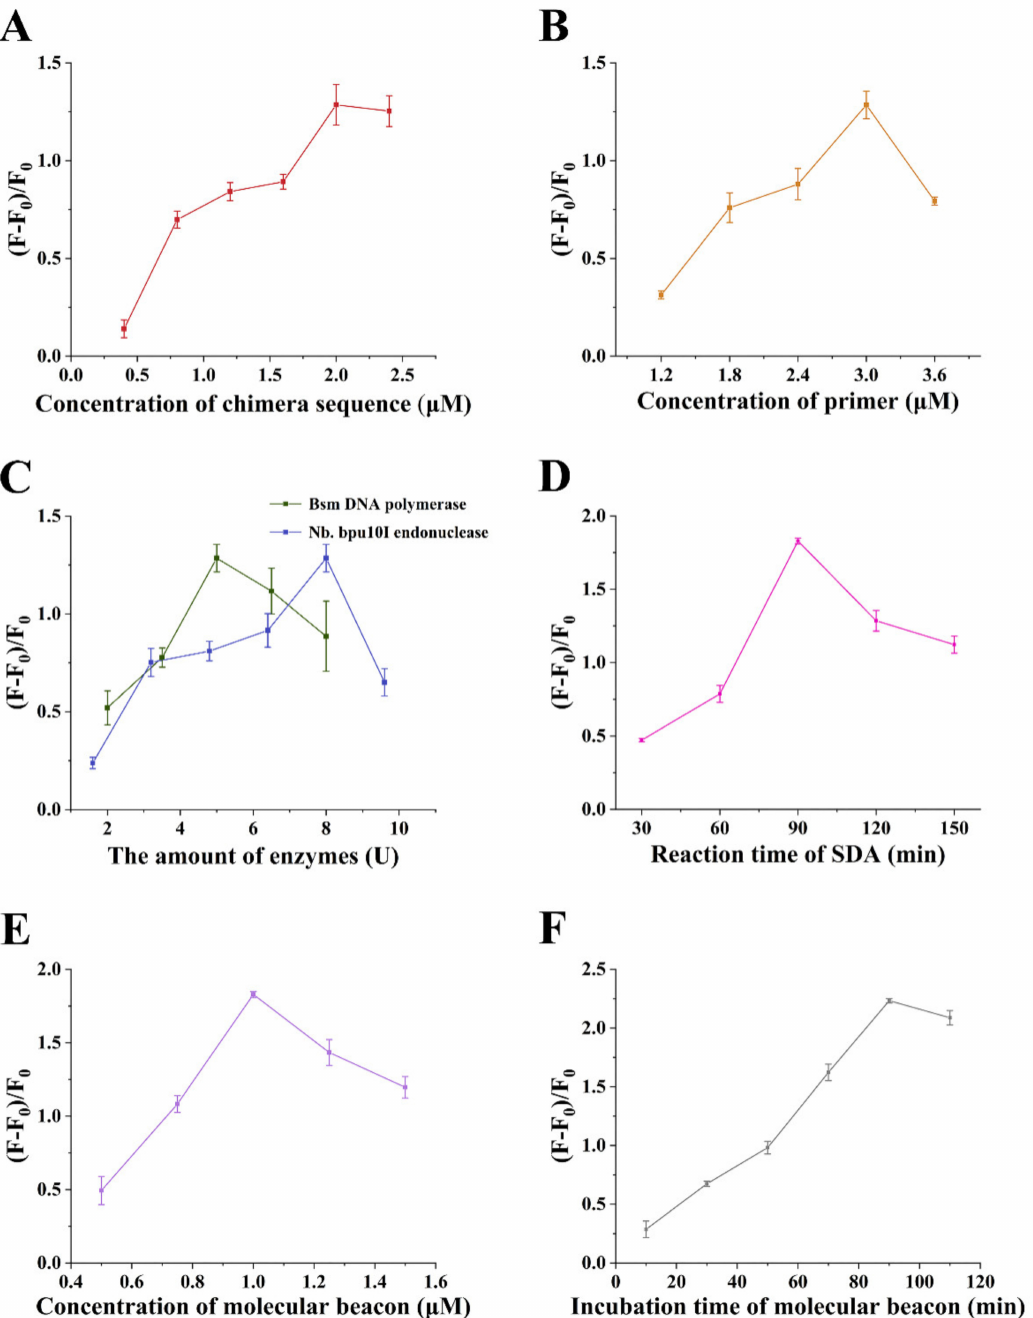
Figure 4. Optimization of the experimental conditions. ( A ) concentration of chimera sequence; ( B ) concentration of primer; ( C ) the amount of Bsm DNA polymerase and Nb.bpu10I endonuclease; ( D ) reaction time of strand displacement amplification (SDA); ( E ) concentration of molecular beacon; and ( F ) incubation time of molecular